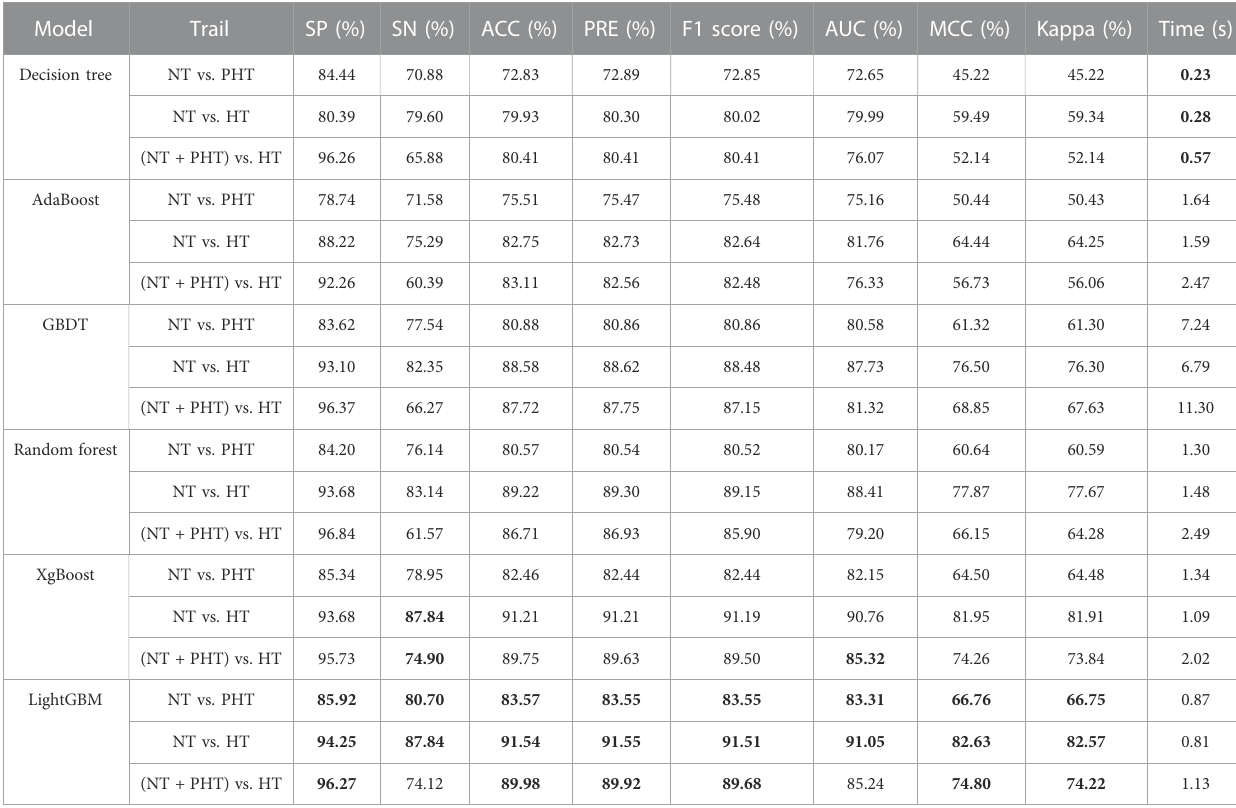
TABLE 2 Classi fi cation performance of the proposed machine learning method. Note, NT, PHT, and HT denote normotension, prehypertension, and hypertension, respectively.SPstandsforspeci fi city,SNstandsforsensitivity,ACCstandsforaccuracy,PREstandsforprecision,MCCstandsforMatthew ’ scorrelationcoef fi cient, KappastandsforCohen ’ skappacoef fi cient,AUCstandsforAreaundercurve.ValuesinBoldindicatehighestscoresachievedforeachclassi fi cationperevaluation metric.